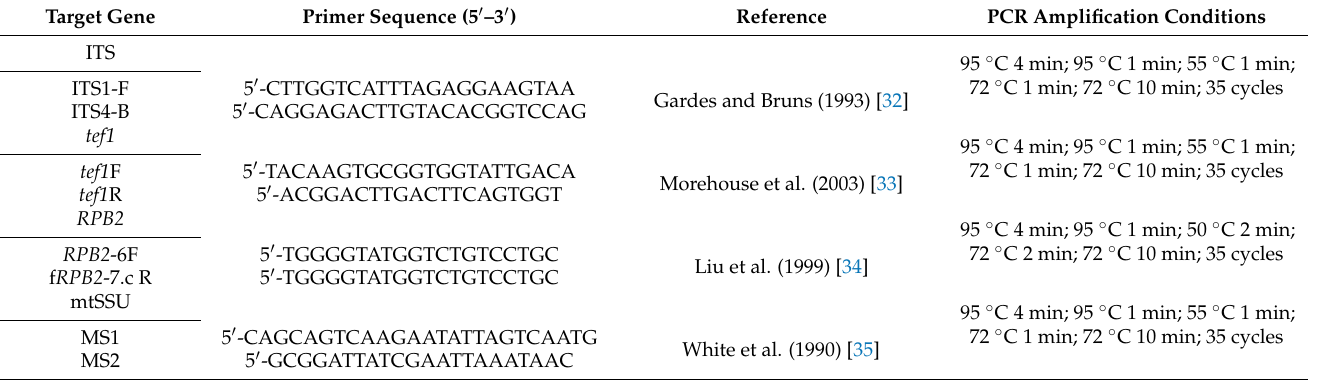
Table 2. Primer pairs used in this study for colony PCR tests (written 5 (cid:48) –3 (cid:48) ). Target